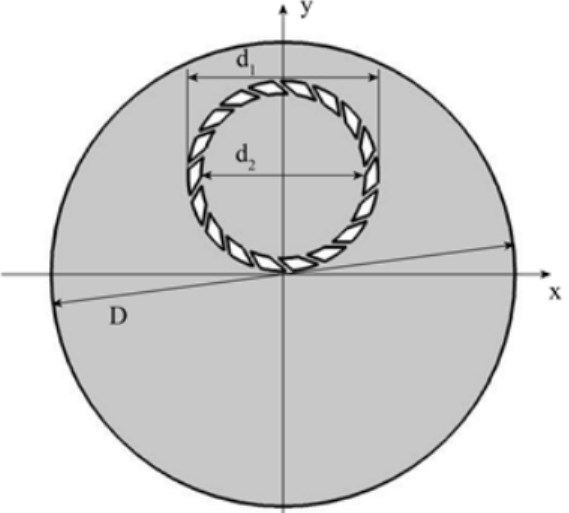
Figure 4. CMP model geometric structure diagram.